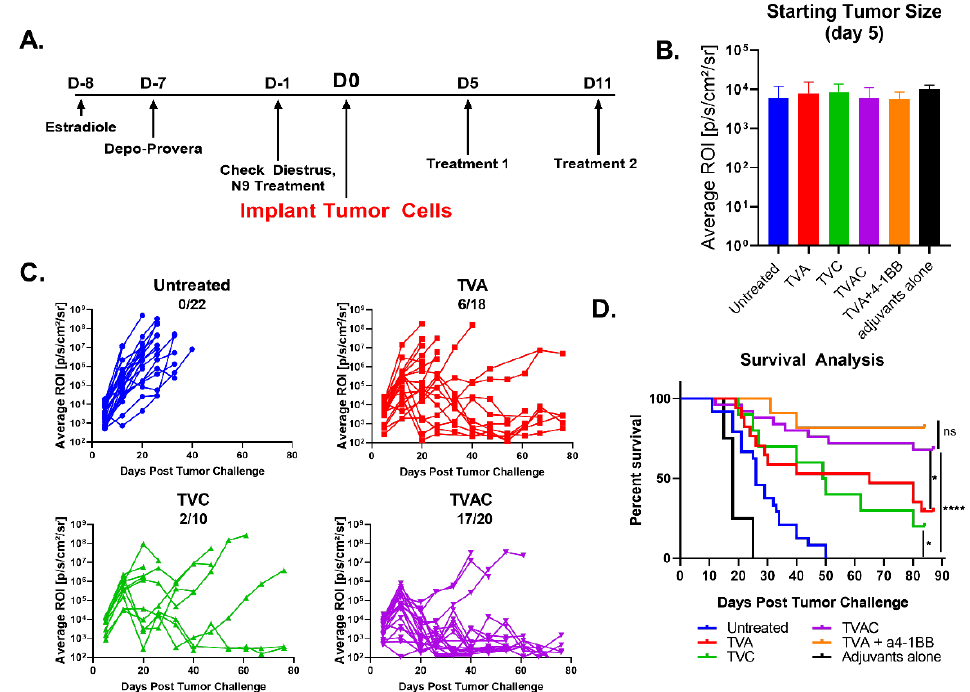
Figure 1. Human papillomavirus (HPV) peptide therapeutic vaccine formulated with the combination of α -GalCer and CpG-ODN adjuvants (TVAC) induces durable regression of established HPV genital tumors. ( A ) Female C57BL / 6J mice ( n = 10 to 22) were hormonally synchronized and challenged with 2 × 10 4 TC-1-Luc cells into the vaginal cavity. Intranasal immunizations using HPV peptide therapeutic vaccine formulated with either α -GalCer, CpG-ODN, or both α -GalCer and CpG-ODN (TVA, TVC, or TVAC, respectively) were administered on days 5 and 11 after tumor cell implantation; control groups included untreated or immunized mice with the mixture of adjuvants without peptides (adjuvants only). ( B ) Mice were size matched on day 5 prior to immunization based on luciferase expression readout, in terms of ROI units. ( C ) Tumor size was measured using luciferase expression (ROI units). The numbers of mice with complete tumor regression over total per group (minimum 10 mice per group) are shown in each panel for the di ff erent groups. ( D ) Survival advantage was recorded between each treatment group as well as the appropriate controls. An additional group of mice receiving intranasal TVA and systemic immunotherapy with agonistic antibody to 4–1BB was included as a positive control based on our earlier published studies for comparing survival rate with that in the TVAC group. Significance in survival proportions was measured using the log-rank test. p < 0.05 (*), p < 0.00005 (****), ns . = not significant.